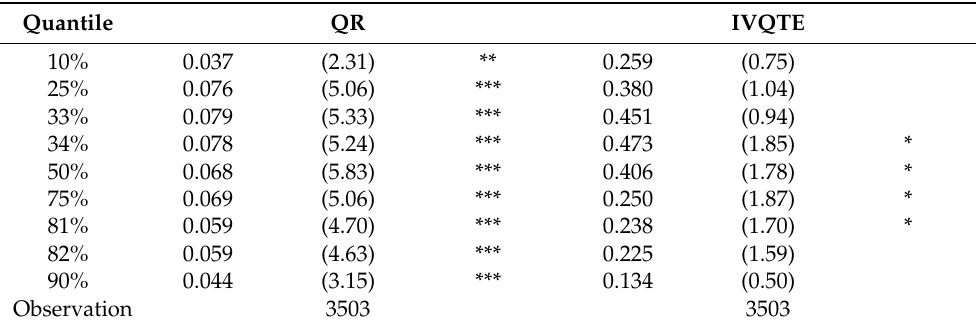
Table 6. Comparison of QR and IVQTE estimation